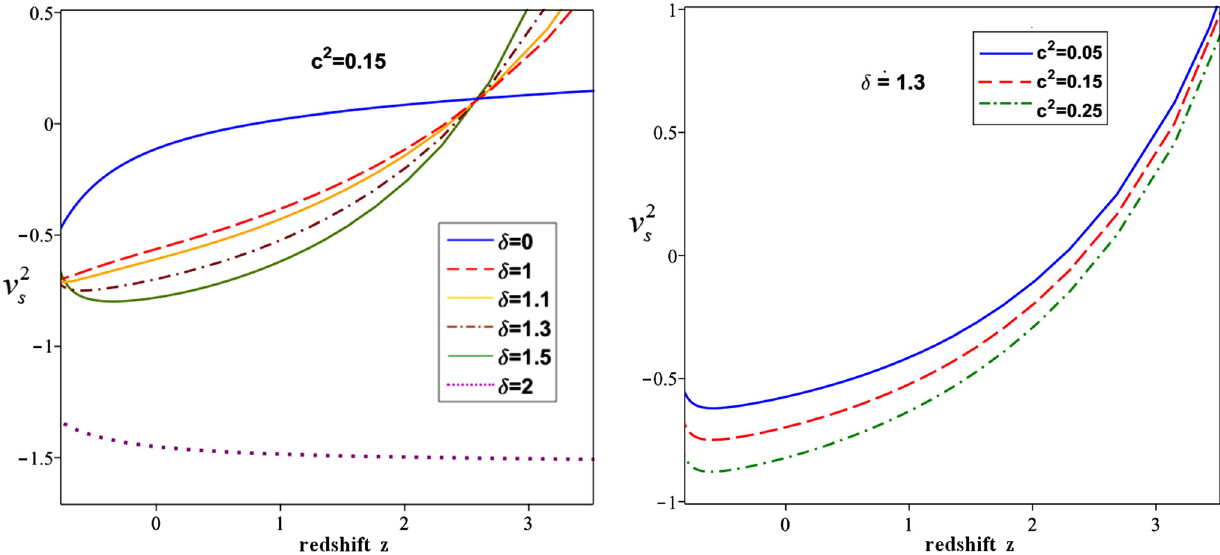
= 0 . 73 and u = 0 . de